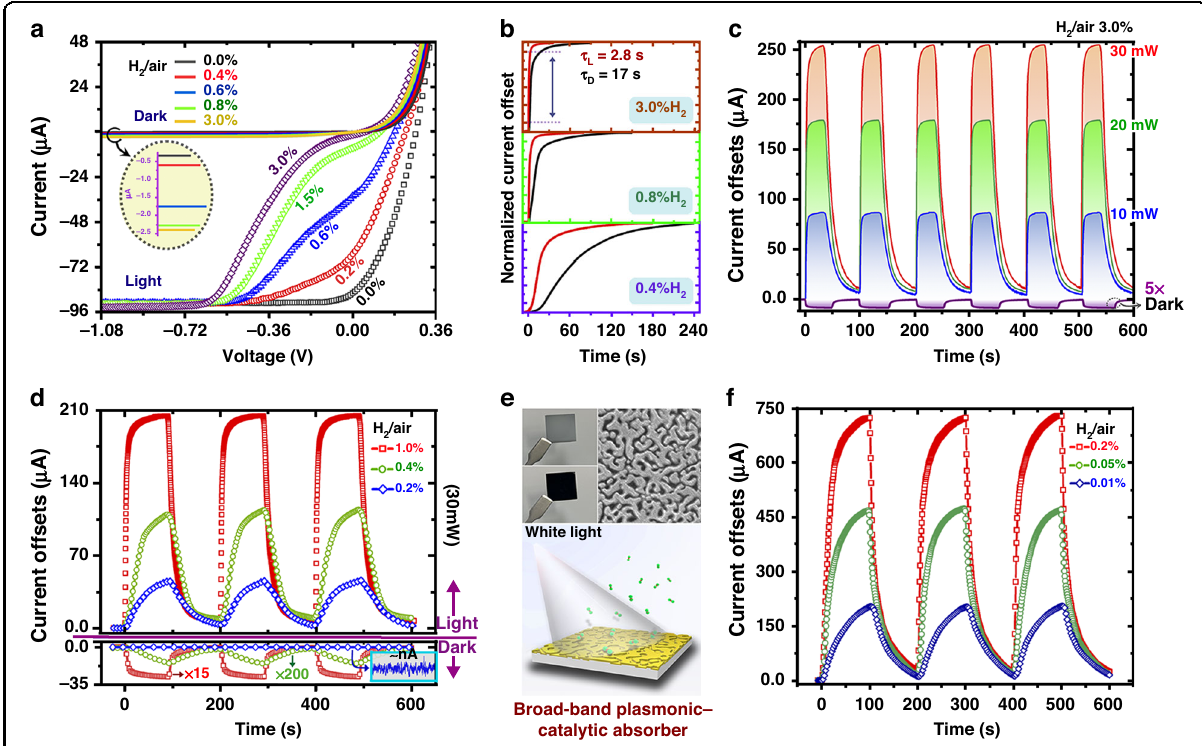
Fig. 5 Hydrogen sensing performance of the plasmonic – catalytic MIS junction devices. a The stabilized light/dark I – V curves of the device under long-time exposure to gas atmospheres containing different hydrogen concentrations. b Time-dependent current response to hydrogen gases. The current offsets of the light and dark mode are normalized to their corresponding stabilized current values. The response rising time (refer to τ L and τ D ) is de fi ned as the time for the incremental change in the output signal to go from 10% to 90% of its fi nal value. c, d Dynamic response of the current for the device upon cyclic exposure to